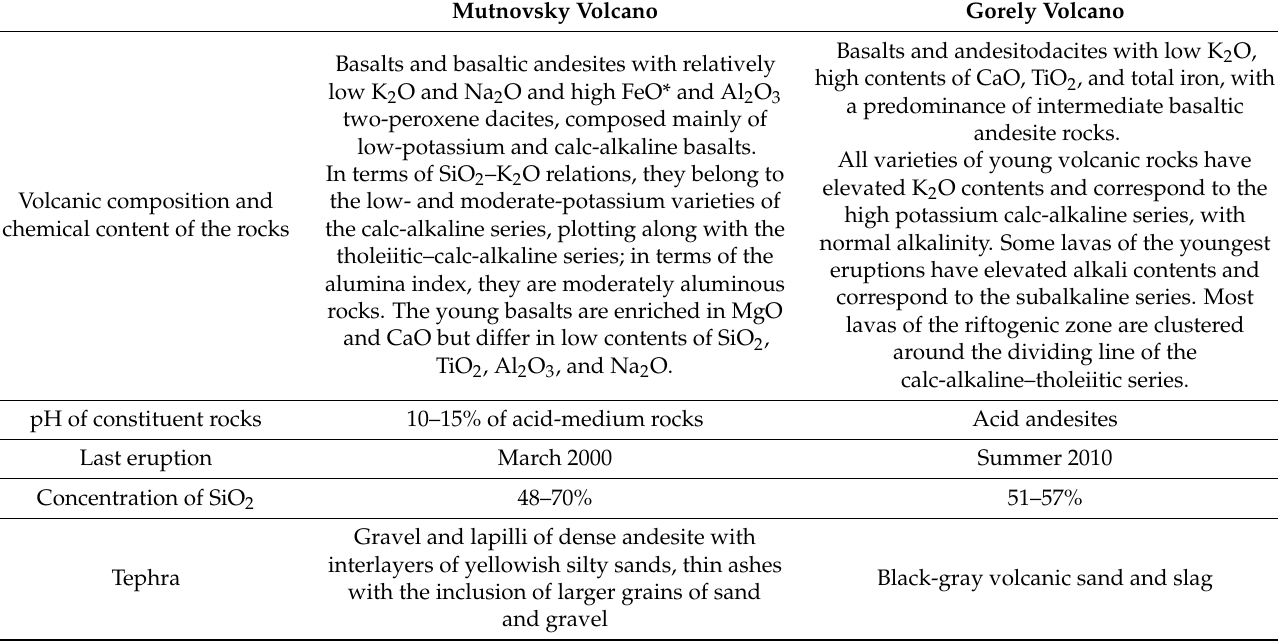
Table 1. Comparisons of the geochemistry of Mutnovsky and Gorely volcanoes [31,47,49,56–59]. Mutnovsky Volcano Gorely